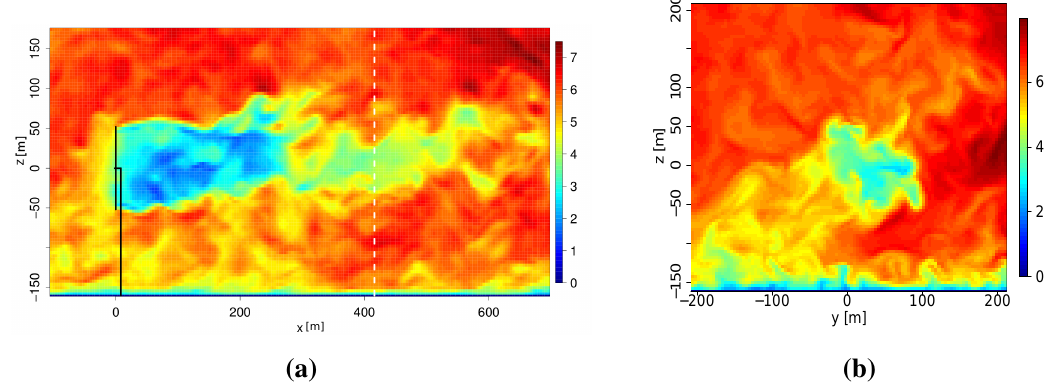
Figure 2. Snapshots of the analyzed LES data. ( a ) xz -plane ( y = 0 m); ( b ) yz -plane ( x = 4 D ). The color contours denote the main velocity component u in ms − 1 . The white dashed line marks the yz -plane at x = 4 D , which was used for the POD